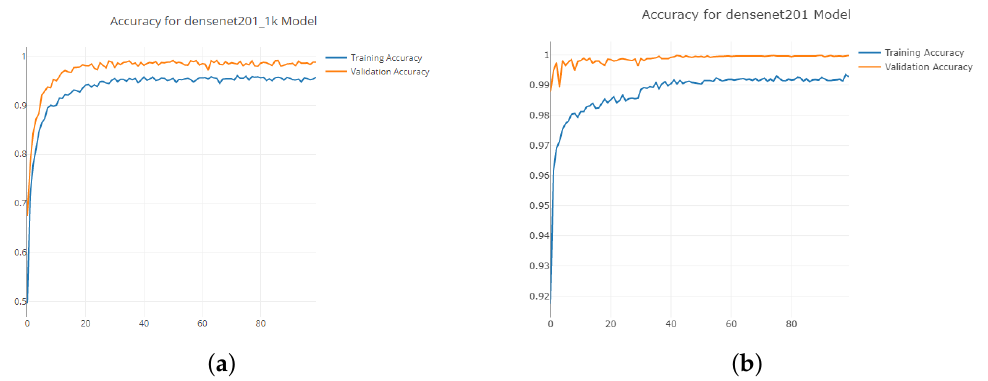
Figure 9. Training accuracy plots across 100 epochs. ( a ) 1000 image dataset, ( b ) 5000 image